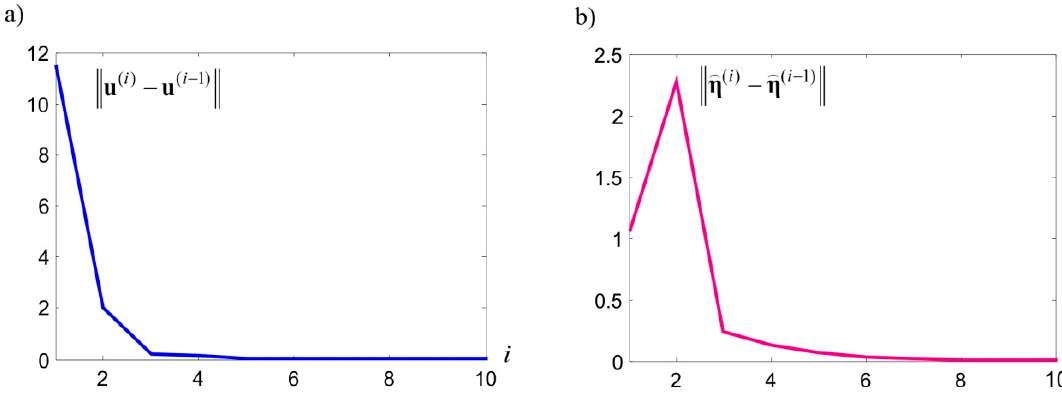
Figure 8. Graphic illustration of ( a ) random displacement and ( b ) surface noise.